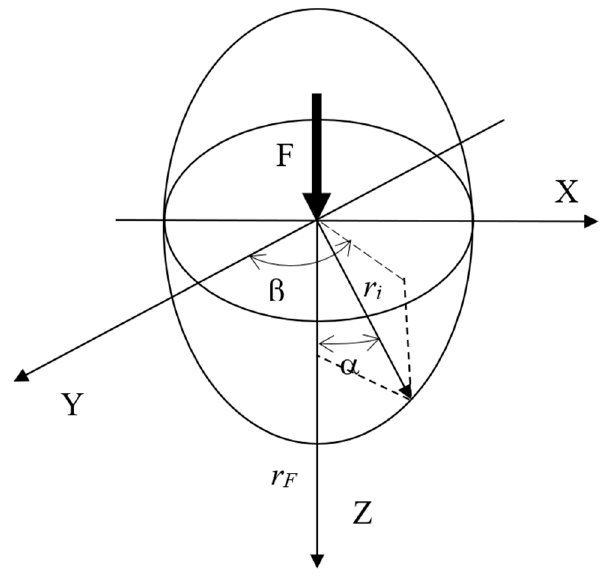
Figure 3. The force field ellipsoid is generated by the F pulse.